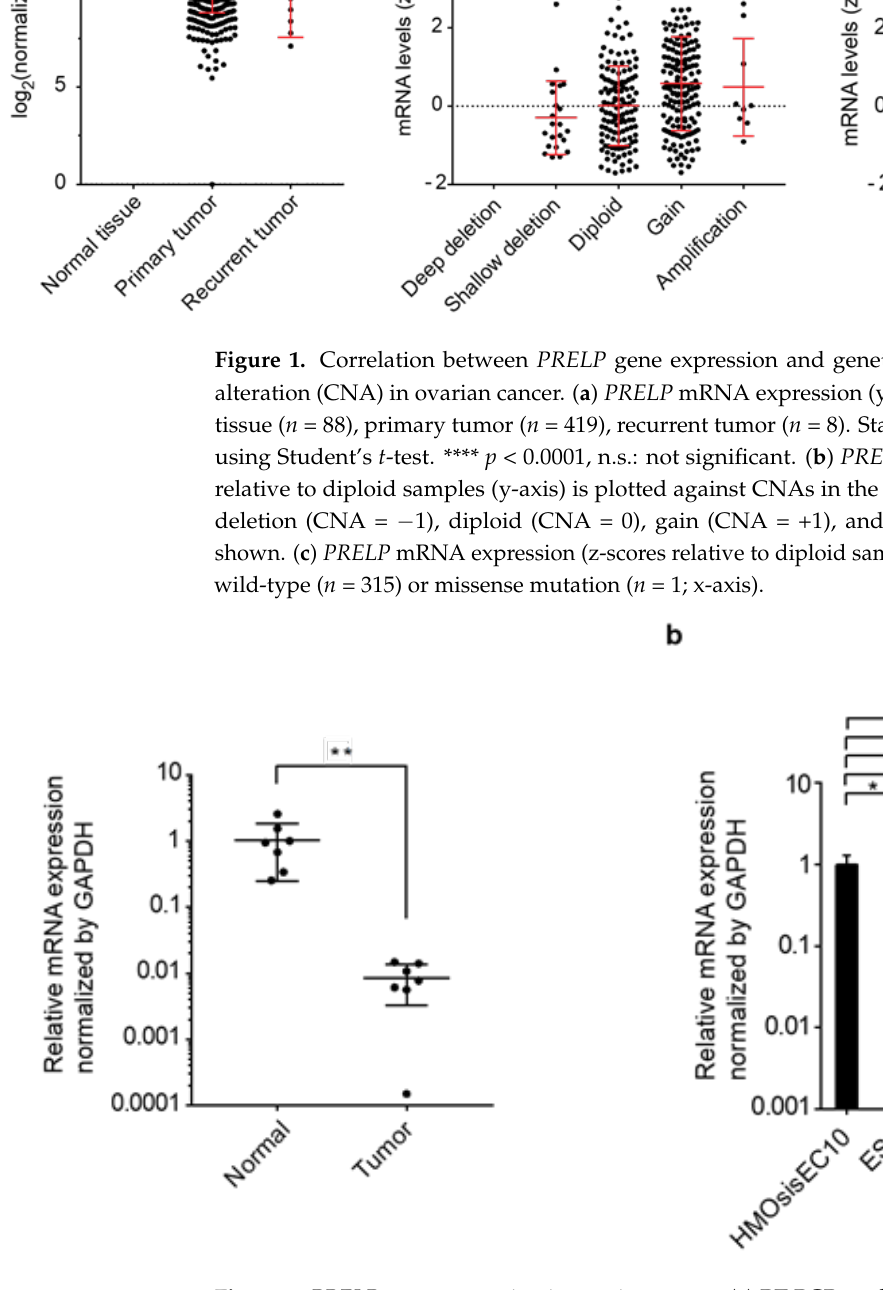
Figure 2. PRELP gene expression in ovarian cancer. ( a ) RT-PCR analysis using ovarian cancer tissue and matched normal ovarian tissue as a comparison. ( b ) RT-PCR analysis using HMOsisEC10, an immortalized human ovarian endometriotic epithelial cell line, and ovarian clear cell carcinoma (OCCC) cell lines. Relative mRNA expression is shown. RT-PCR was performed in triplicate for each sample. Statistical analysis was performed using Student’s t -test. * p < 0.05; ** p < 0.01.